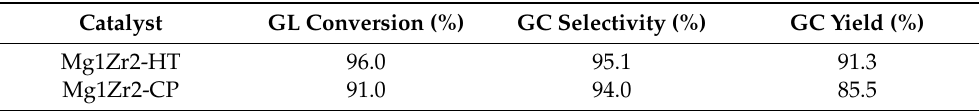
Table 2. Catalytic performance of Mg1Zr2-HT and Mg1Zr2-CP for transesterification of GL with DMC. Catalyst GL Conversion (%) GC Selectivity (%) GC Yield (%)